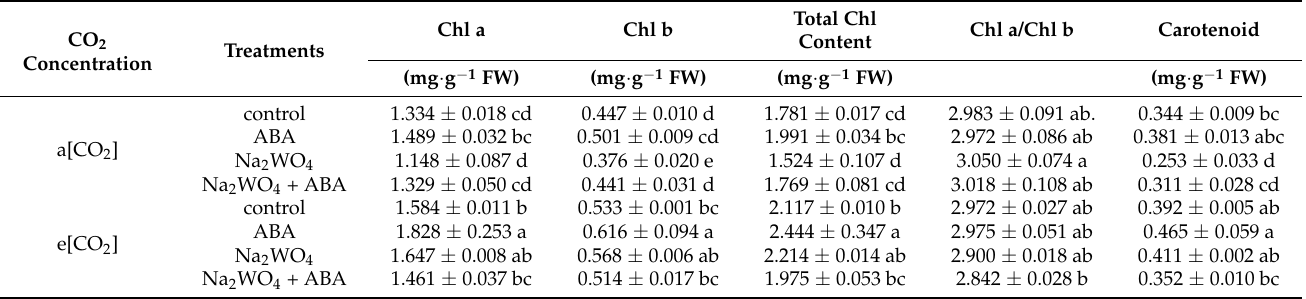
Table 2. Effects of elevated CO 2 and exogenous ABA on photosynthetic pigment content of cucumber seedlings under drought